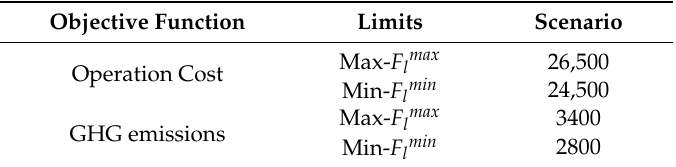
Table 1. Limits in the objective functions allowing the virtual power plants (VPP) to select the best solution.